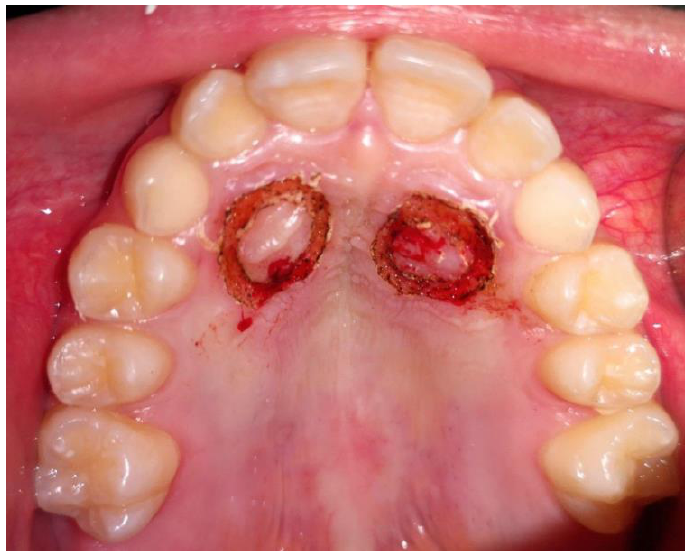
Figure 3. Post-operative photo.